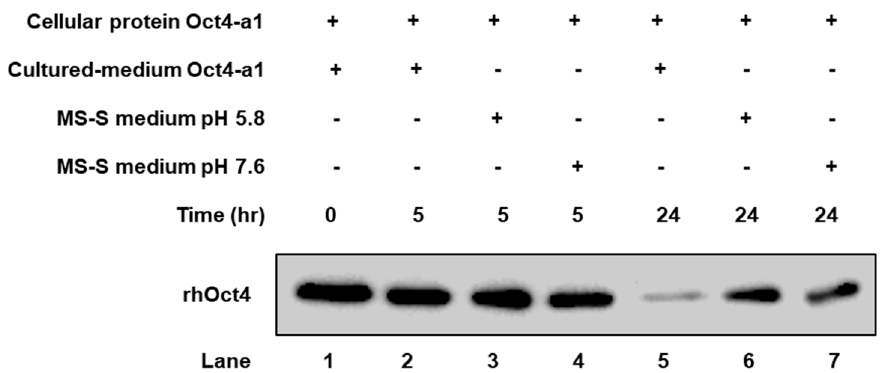
Figure 3. Analysis of rhOct4 protein stability in rice cell suspension culture medium. Cellular proteins extracted from Oct4-a1 suspension cells sugar-starved for two days were incubated with a cell-culture medium of Oct4-a1, fresh MS medium with pH 5.8, or fresh MS medium with pH 7.6 for 5 or 24 h. The rhOct4 abundance was determined by western blot analysis with human Oct4 antibodies.